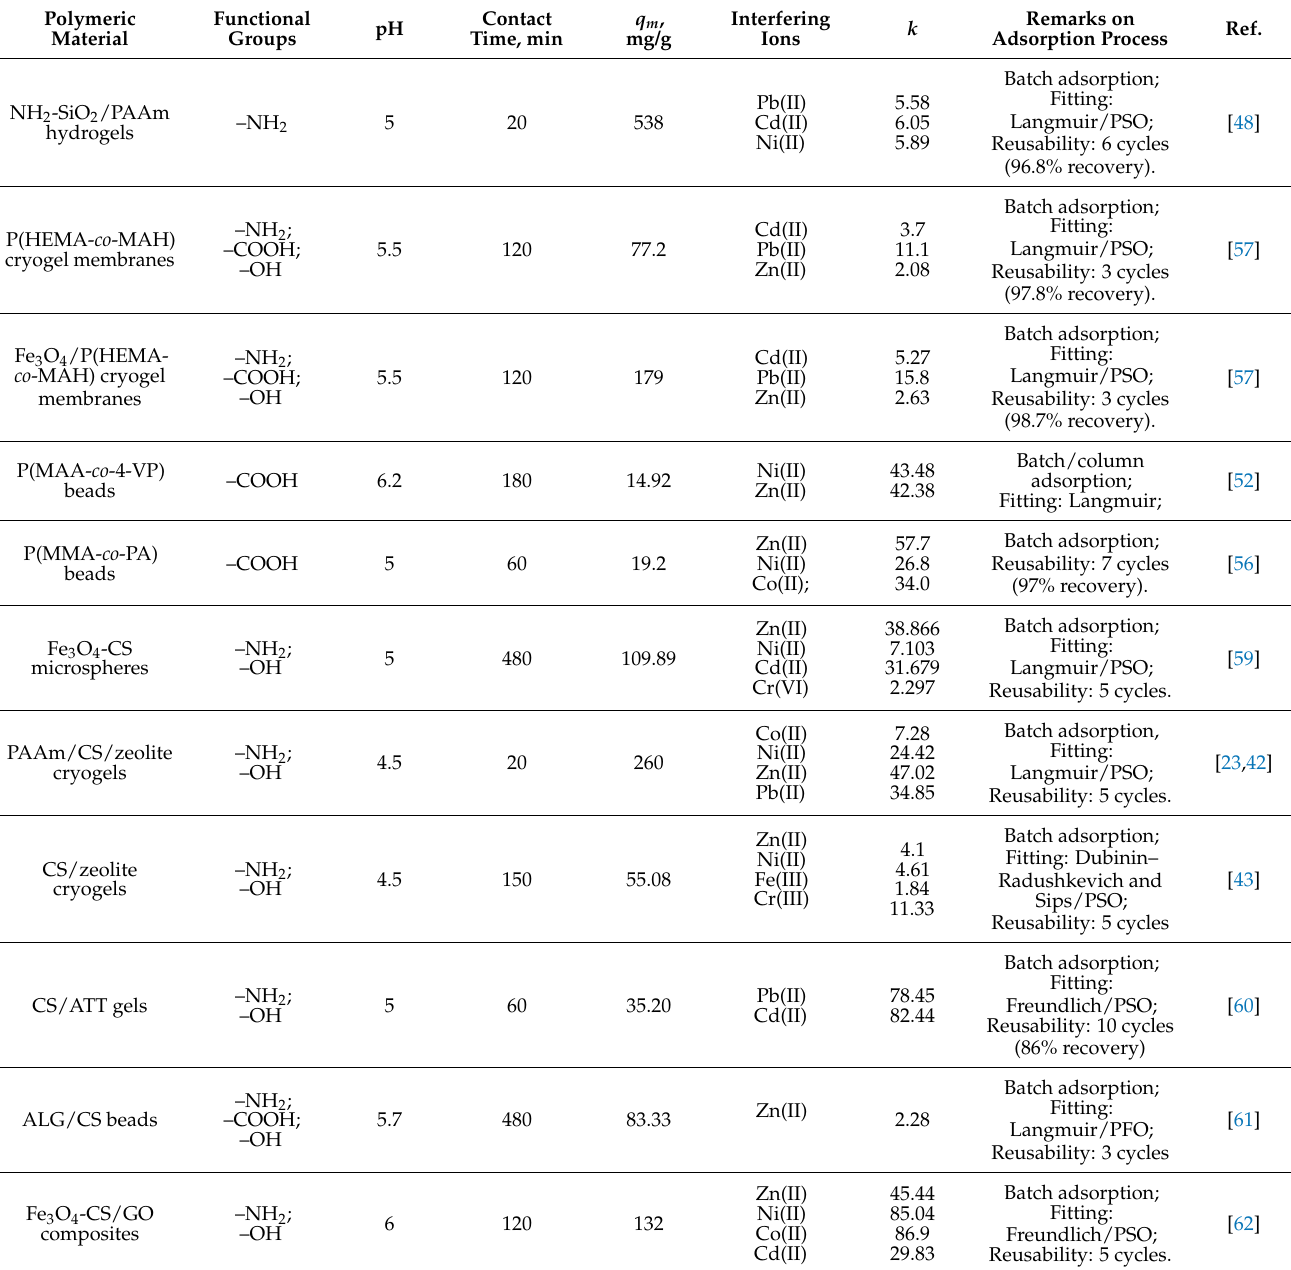
Table 2. Selective extraction of Cu(II) ions by IIP